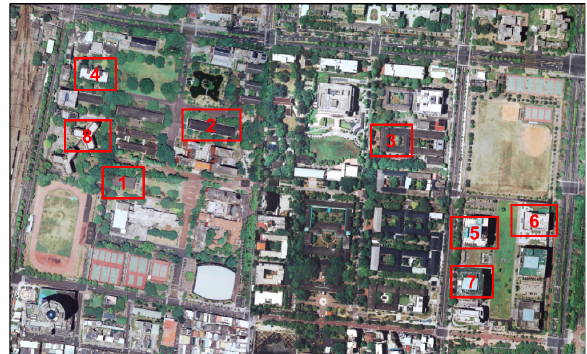
Figure 11. The aerial image of test area and the selected test objects.